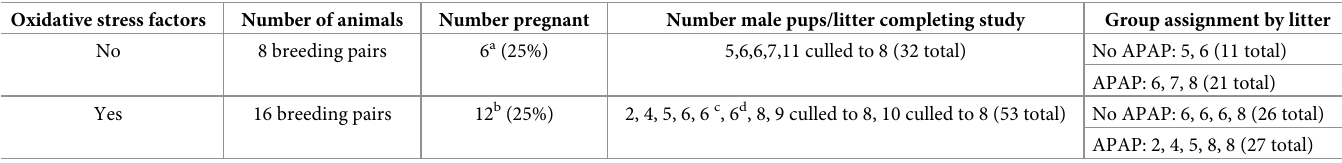
andraspeter.com/). Behavioral bins were as follows: exploration, play, investigation, chasing,